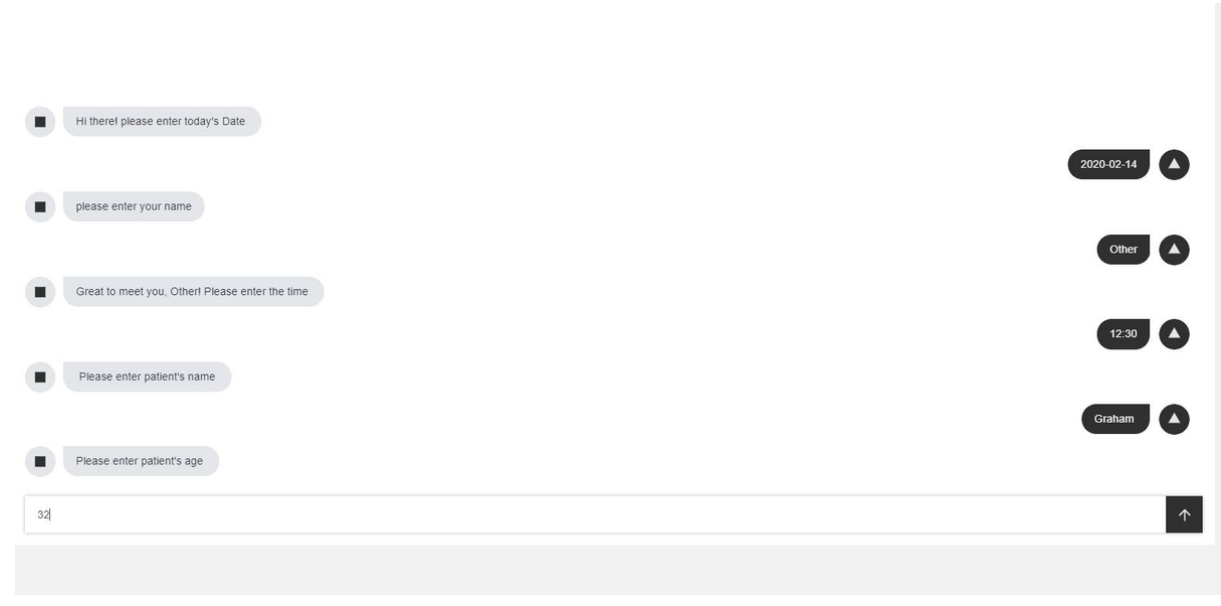
Figure 4. Screenshots of the conversational form.